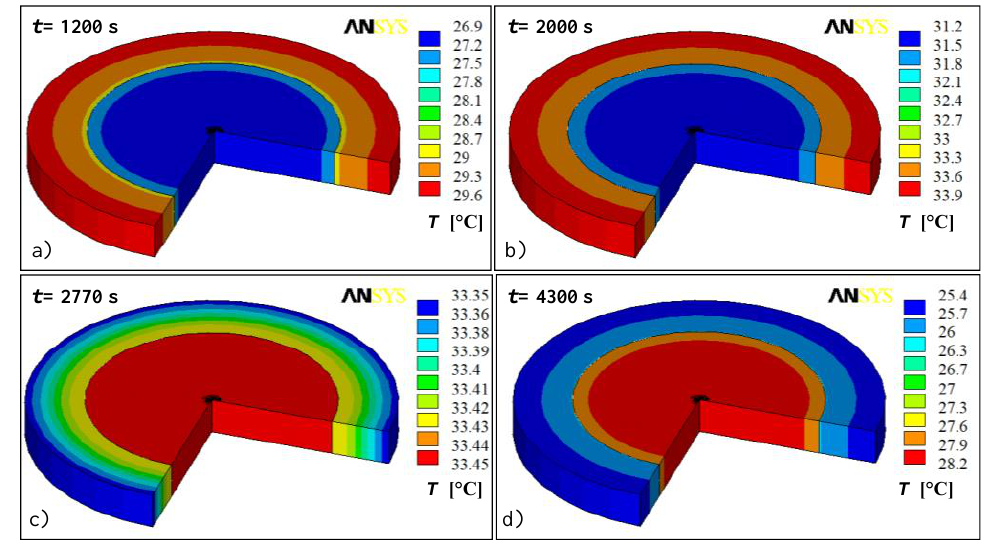
Figure 11. Temperature distribution in probe 1 at chosen times during its heating by 10 °C and subsequent cooling in the climate chamber, ( a ) t = 1200 s, ( b ) t = 2000 s, ( c ) t = 2770 s and ( d ) t = 4300 s.